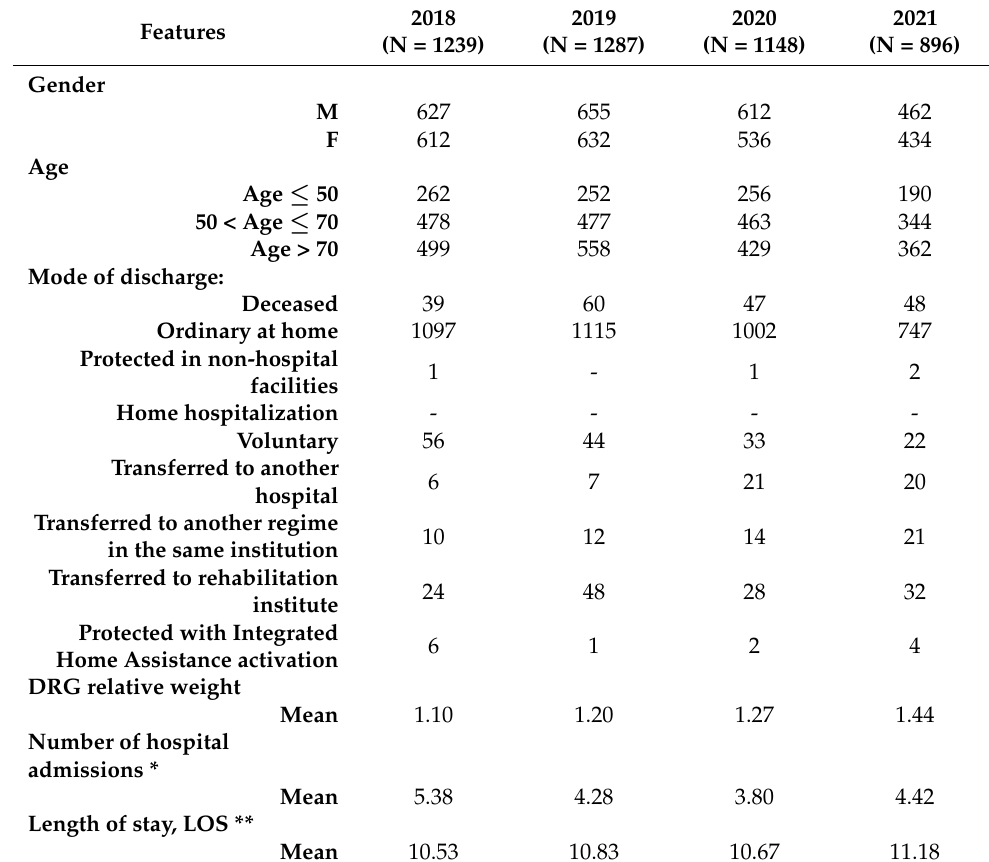
Table 3. Study population